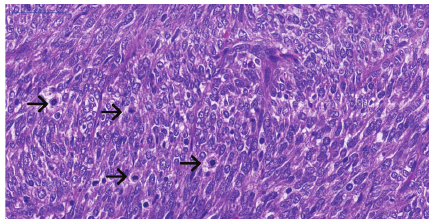
Figure 1: Tumor cells with bland-looing, ovoid to spindle nuclei. Numerous mitotic figures are identified (H&E stain 40x).